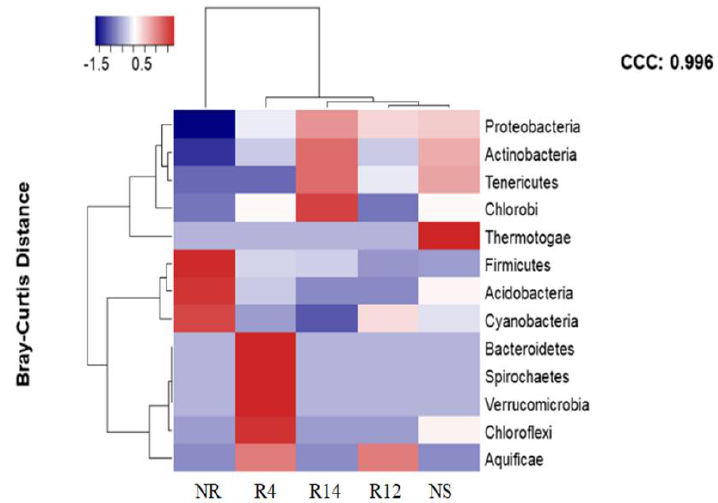
Figure 5. Clustering based on the relative abundance of peptides from bacterial phyla. The Bray − Curtis distance index was used, cophenetic correlation coefficient (CCC) = 0.996. Heatmap function in R. The color scale shows the phyla abundance between areas.